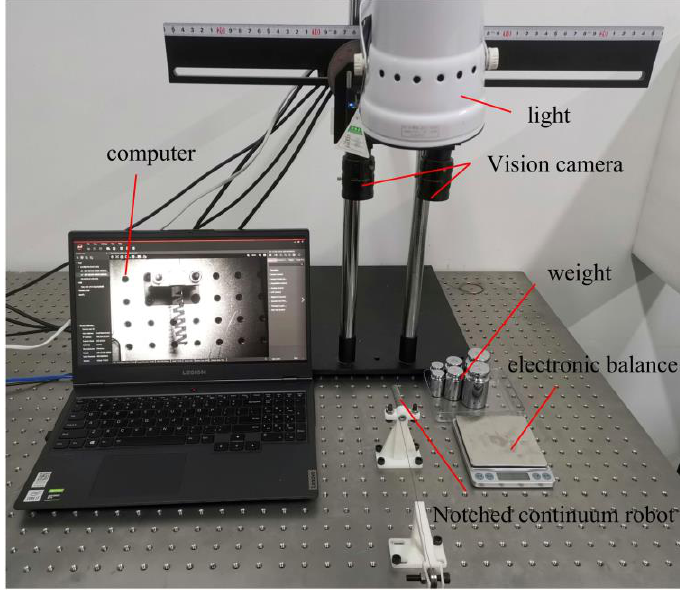
Figure 9. Experimental setups for the mechanics model verification.